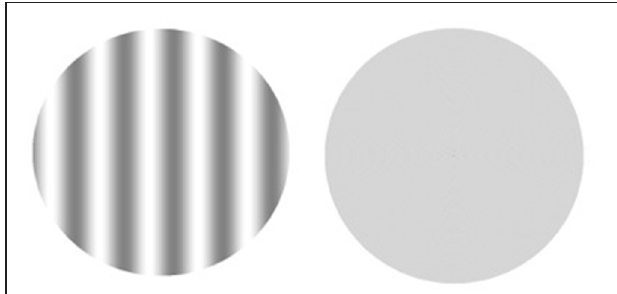
FIGURE 1 | Example of a pair of stimuli. The left side shows the 0.25cpd spatial frequency, and the right side shows the neutral stimulus. The stimuli were originally calibrated to be seen at a distance of